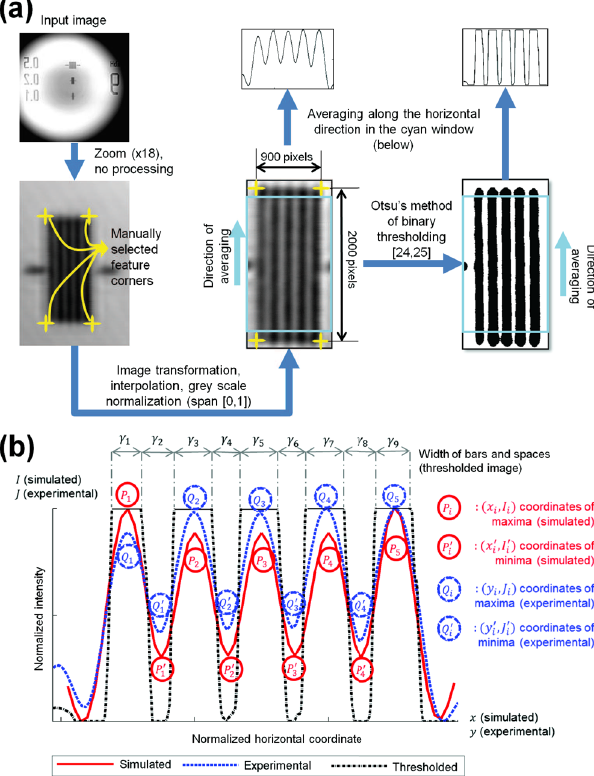
FIG. 4. Binary thresholded image and cross-section curves, and their notations. Panel (a) shows the image processing steps done to obtain the binary thresholded image and the cross-section curves for the experimental and the thresholded images. Panel (b) shows the notations used in (a) for deriving quantitative metrics of image quality of the feature.